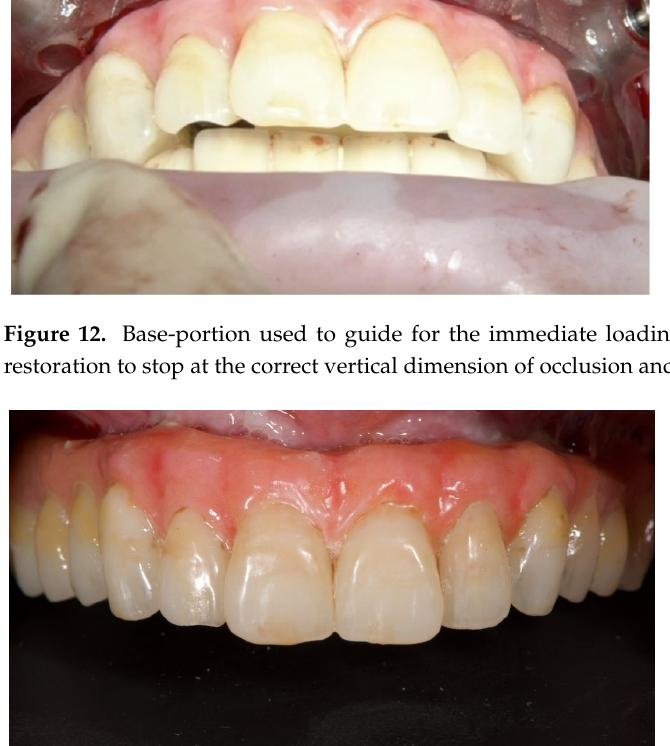
9 Figure 10. Base-portion in the patient’s mouth used as reference guide during the bone reduction. Figure 11. Base-portion plus implant-portion. Multi abutment units were screwed onto the implants and the flap was sutured. A fixed, screw-retained, temporary restoration, without cantilever, was delivered. The